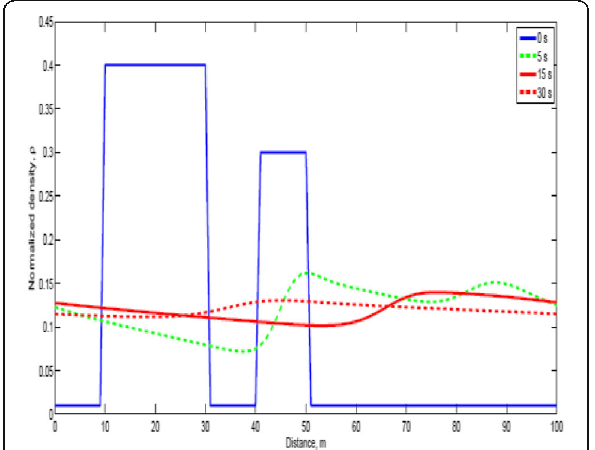
Fig. 2 The proposed model density behavior with b =